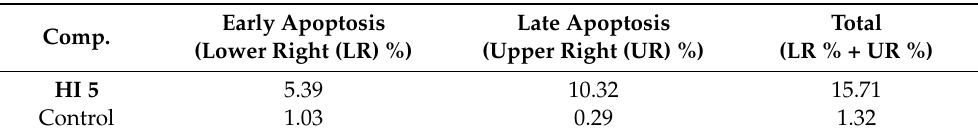
Table 2. Distribution of apoptotic cells in the AnnexinV-FITC/PI dual staining assay in MCF-7 cells after treatment with HI 5 .